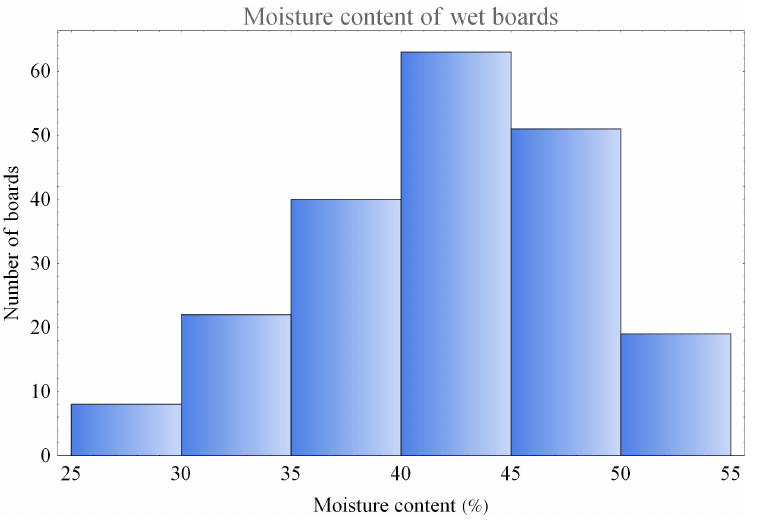
Figure 11. Moisture content of wet